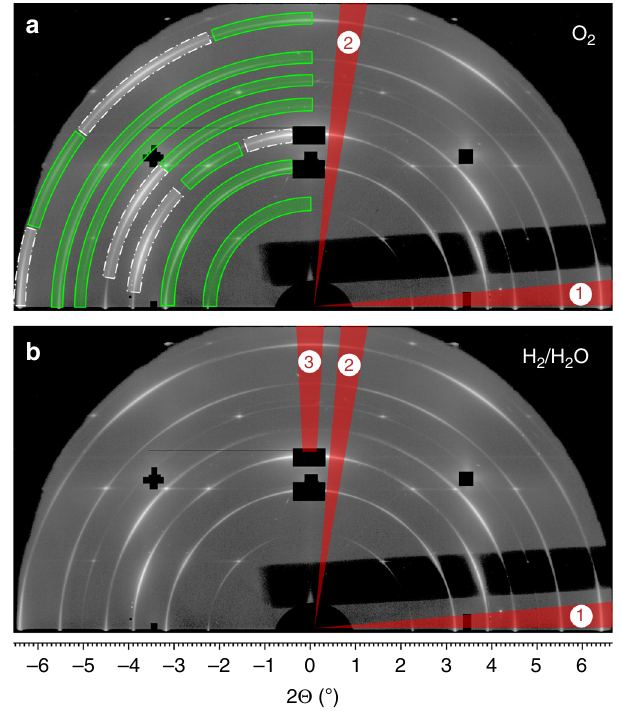
Fig. 2 2D diffraction patterns measured on pristine La 0.6 Sr 0.4 FeO 3- δ thin fi lm electrodes with buried Pt current collectors at 625 ± 10 °C in two different atmospheres. The black parts are beam stops (either physical or digital ones) to block signal with a too high intensity. a Atmosphere: 5% O 2 /balance Ar. The circular segments in the left part of the pattern indicate different phases (gray/dash-dotted: Pt, green/solid: La 0.6 Sr 0.4 FeO 3- δ ), while the numbered red triangles show different integration regions. b Atmosphere: 2.5% H 2 /0.25% H 2 O/balance Ar. For the sake of better visibility the phase identi fi cation was omitted here. On patterns measured under reducing conditions a third integration region was applied for comparison with samples after Fe exsolution.